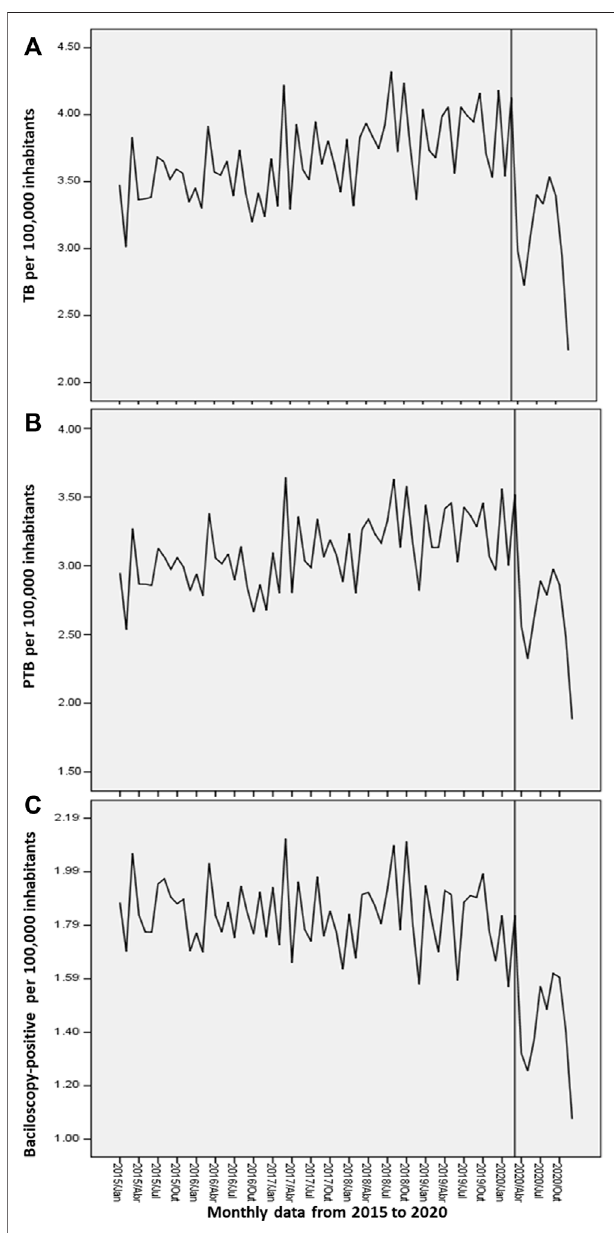
FIGURE 2 | Interrupted time series analysis of tuberculosis cases in Brazil: (A) New cases of tuberculosis (TB); (B) New cases of pulmonary tuberculosis(PTB); (C) Baciloscopy-positive(AARB+)cases.Thelinethatcuts each time series indicates the intervention in the series, in this case, the onset of the COVID-19 pandemic in Brazil in March